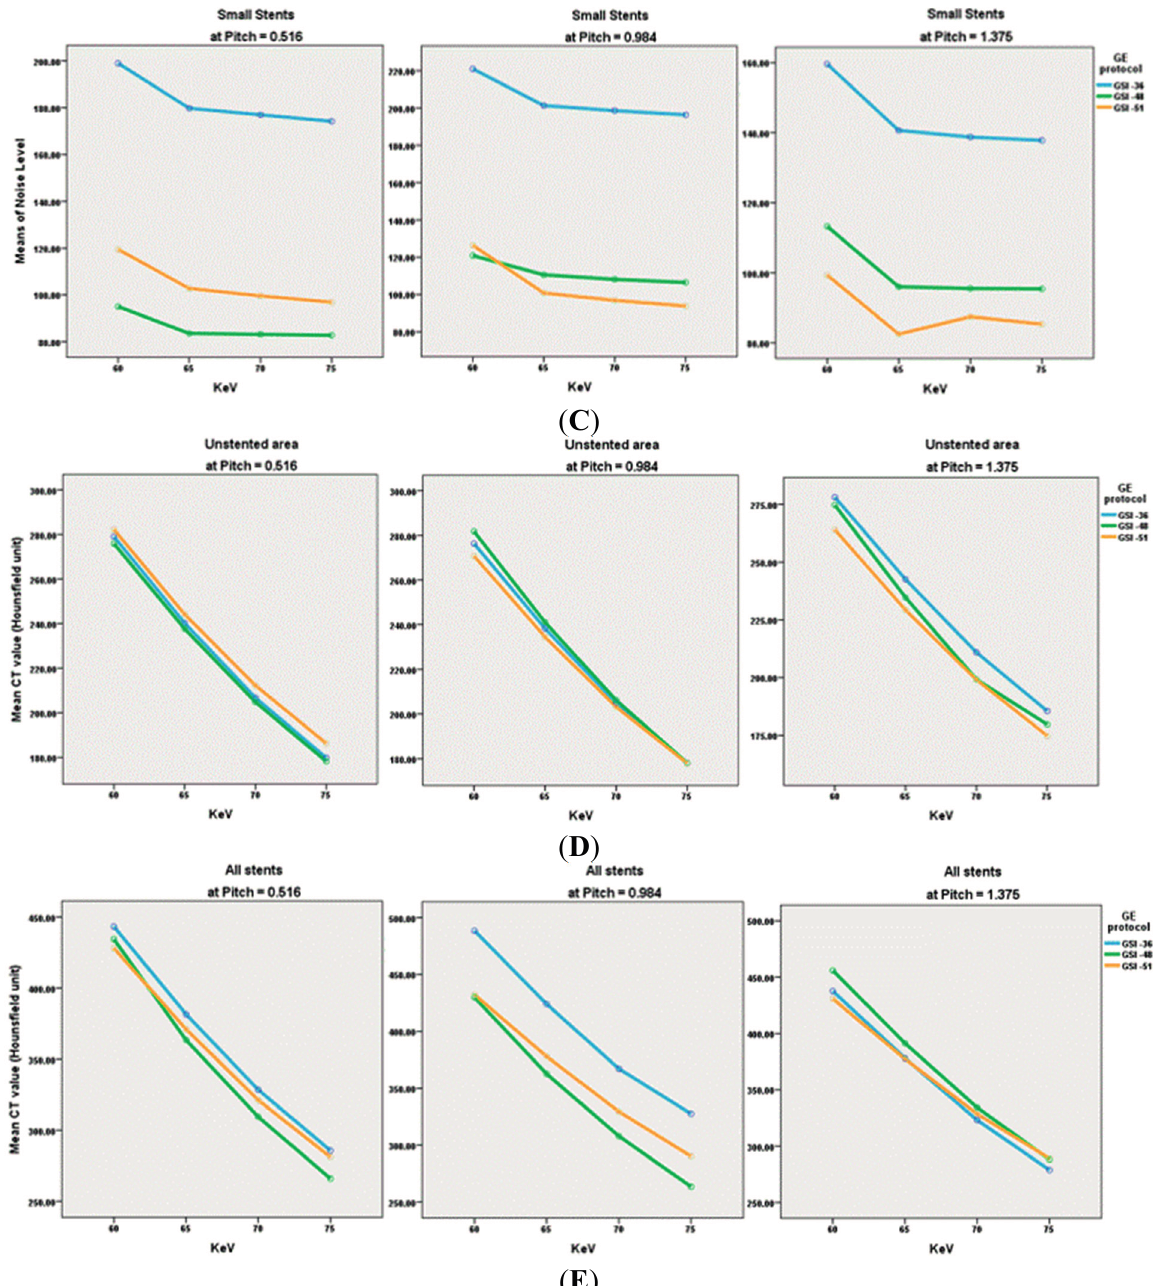
Figure 1. ( A – C ) show the comparison of Noise Level at different kiloelectron voltage (keV) with the three preset GSI protocols and three pitch values, while Figure ( D , E ) represent the mean of CT value in unstented area and all stents with these scanning